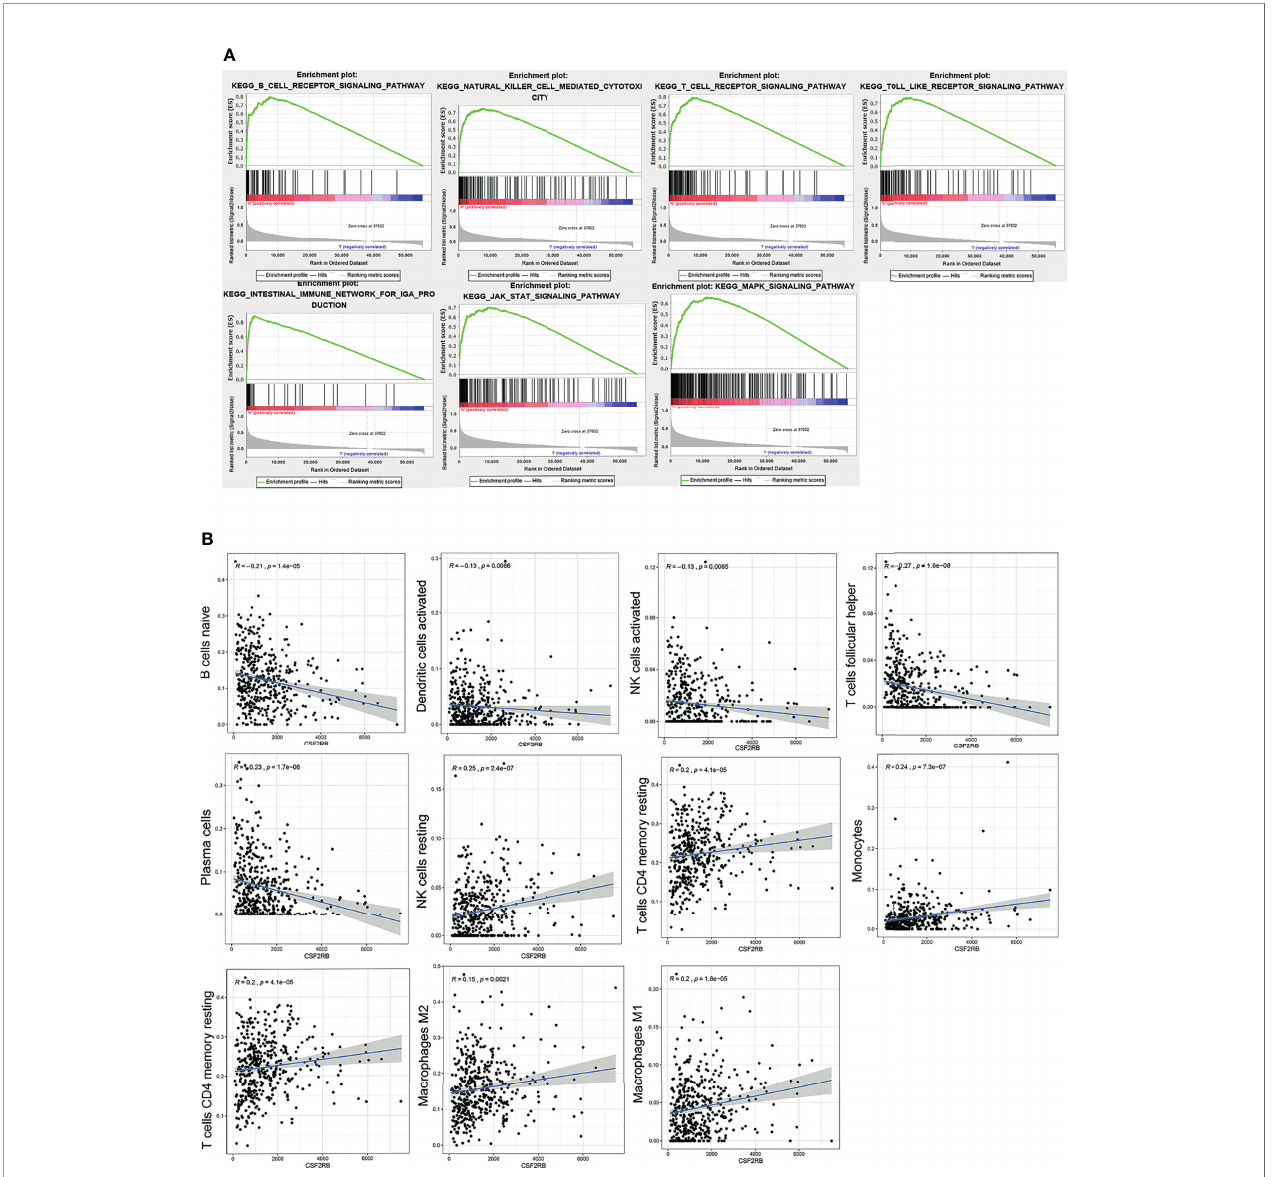
FIGURE 5 | GSEA analysis of CSF2RB gene. (A) Immune activation processes were enriched in the CSF2RB high expression group of LUAD. The JAK/STAT and MAPK signaling pathways were enriched in the CSF2RB high-expression group of LUAD. (B) The correlation analysis between CSF2RB and in fi ltrated immune